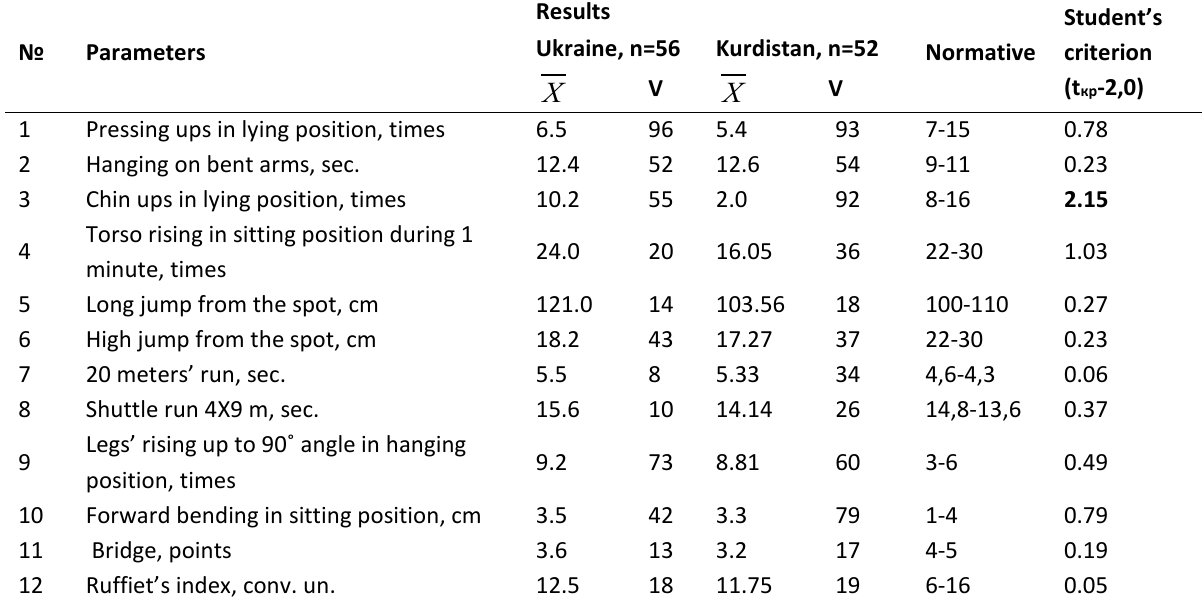
Table 3. Physical fitness level of 7 years’ age boys from Ukraine and